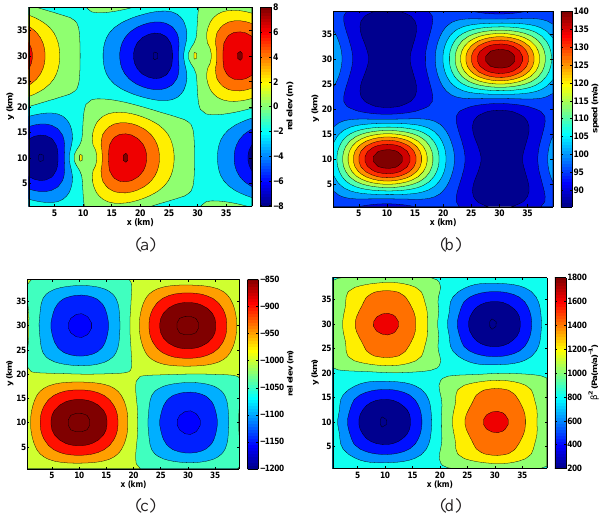
Fig. 8. An inversion similar to Figs. 6-7, but with β 2 true ”in phase” with R true , such that the sticky spots coincide with the topographic minima. Initial guesses for R and β 2 are the same as before. (a) Steady state surface elevation with trend removed. (b) Steady state surface velocity. (c) Inverted basal topography. rms error is 16 m. Inverted topographic minima are smaller in amplitude than the ”true” topography by ∼ 50. This is compensated by lower β 2 in those regions (d).